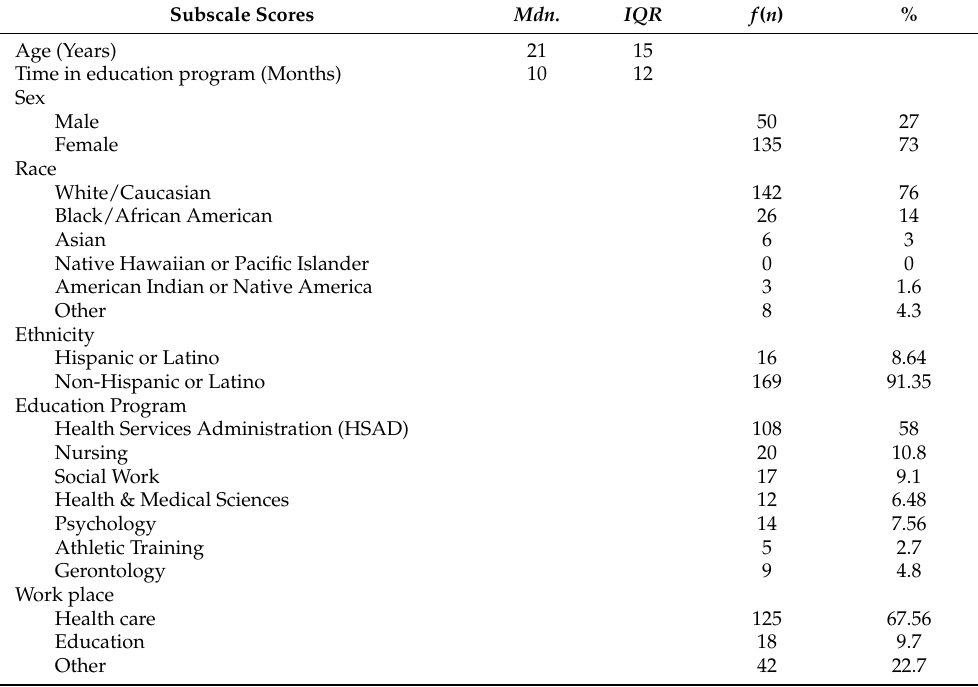
Table 1. Characteristic of Sample ( N = 185). Subscale Scores